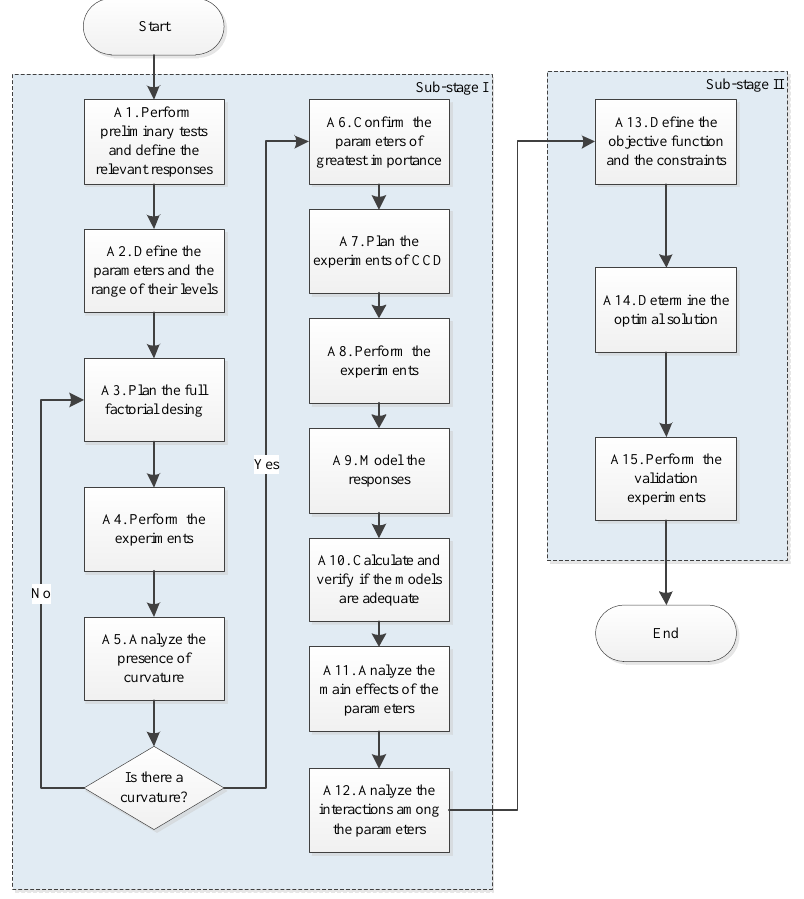
Figure 6. Flowchart of the stage I.